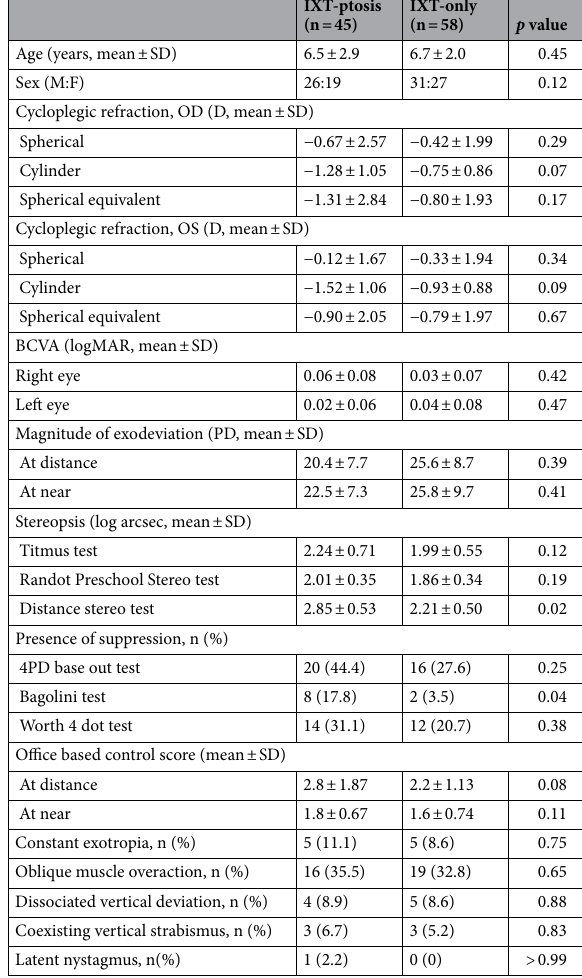
Table 1. Baseline characteristics and clinical features : comparison between the IXT-ptosis and IXT-only groups. BCVA best-corrected visual acuity, D dioptre, IXT intermittent exotropia, MAR minimum angle of resolution, PD prism diopters, SD standard